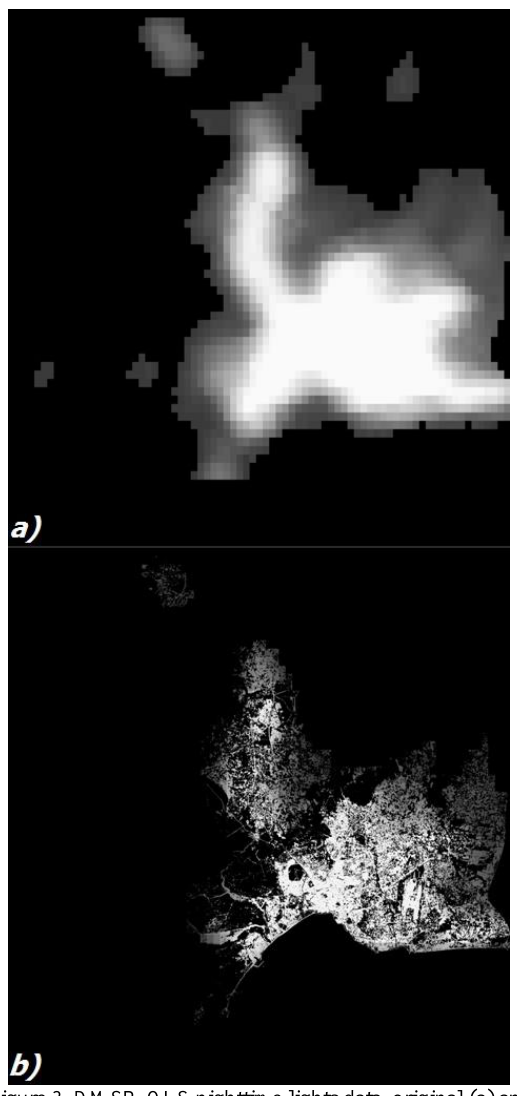
Figure 3. DMSP_OLS nighttime lights data, original (a) and enhanced